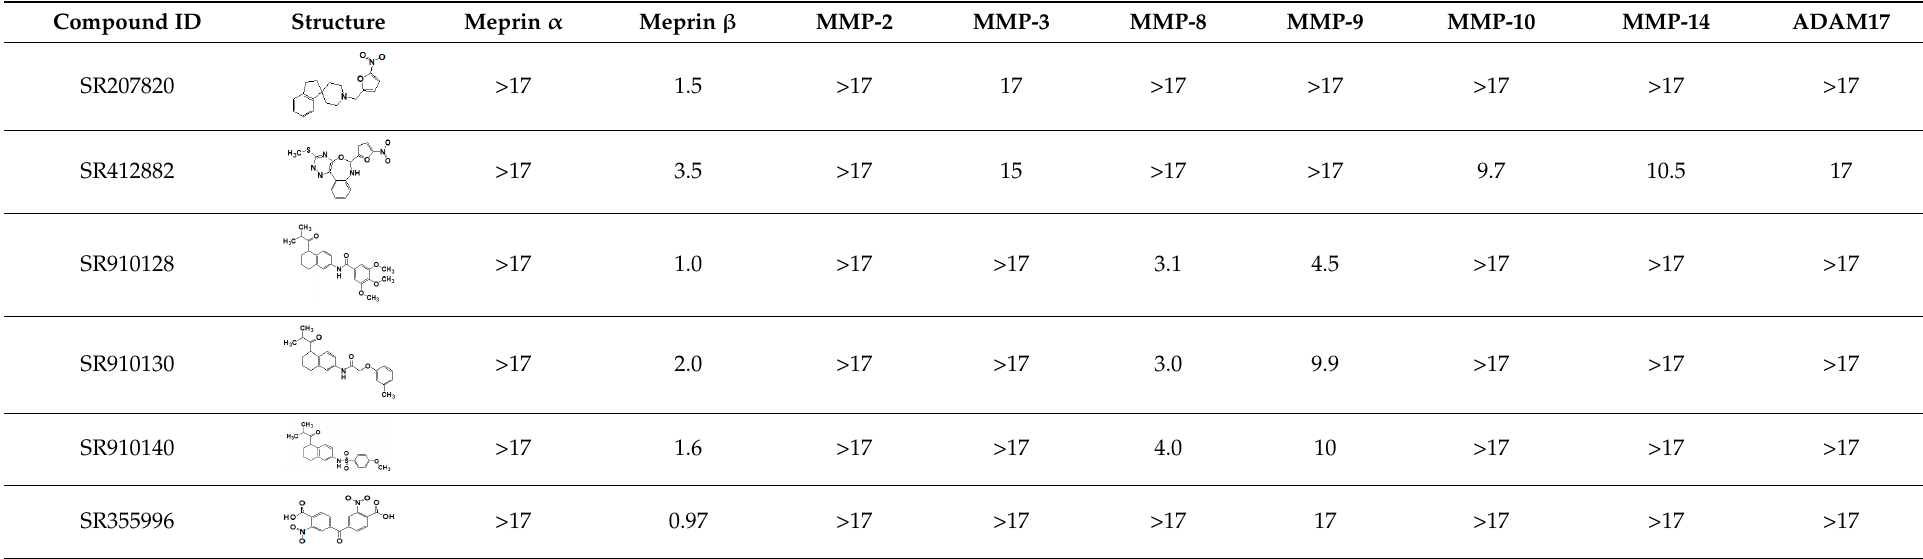
Figure 7. Results of concentration response studies of top potent and selective meprin β inhibitors. Table 3. Selectivity testing of meprin β top HTS hits. All units are IC 50 , µM.